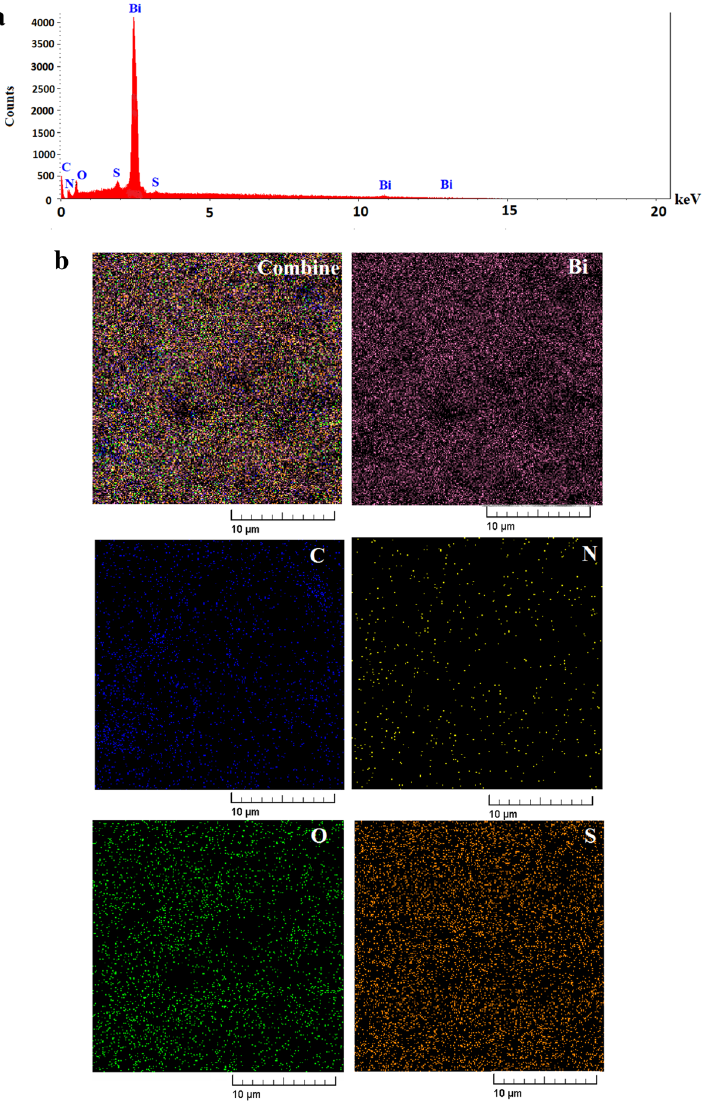
Figure 5. EDS-mapping of Bi 2 O 3 /Gln-TSC NPs. The spectrum shows the presence of Bi, O, N, C and S elements in the final product (Bi 2 O 3 /Gln-TSC) ( a ). Also, the maps blow the spectrum show the distribution of Bi, O, N, C and S elements in the final product ( b ).